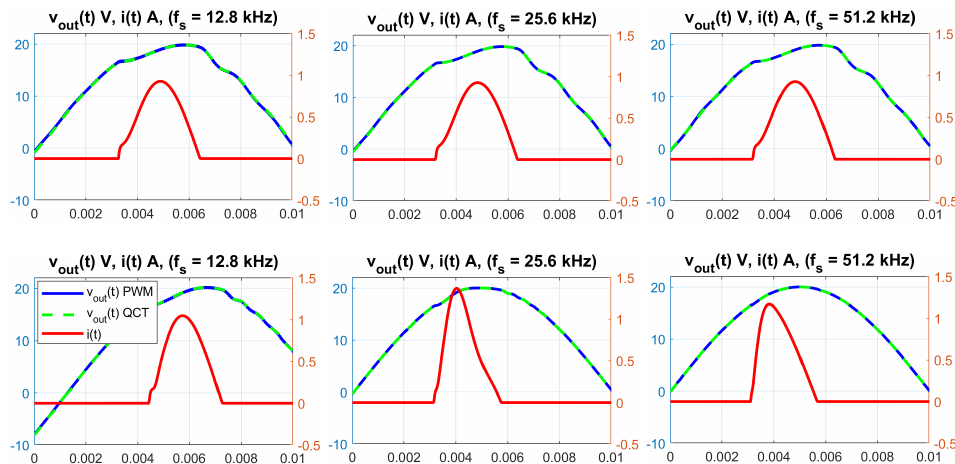
Figure 7. Output voltages v out ( t ) and load currents i ( t ) under rectifier load for three sampling rates. Top row: uncontrolled system; bottom row: optimally tuned PID controlled systems with ∆ A = 1.1. Blue lines: output from PWM simulation, green lines: output from QCT simulation.